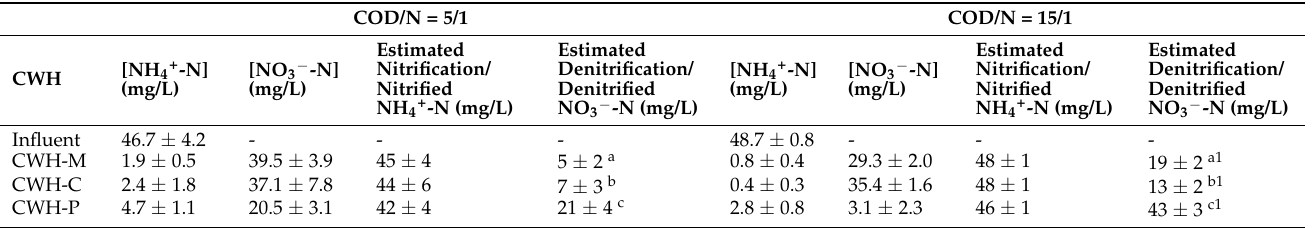
Table 2. Influent and effluent NH 4+ -N concentration, effluent NO 3 − -N concentration, estimated nitrification, and denitrification (mg/L) with standard error in CWH over the experimental period at both COD/N ratios. CWH-M, CWH-C, and CWH-P indicate mineral wool, cocopeat, and pumice without plants, respectively. The denoted values of (a and a1), (b and b1), (c and c1), (a and c), (b and c), and (a1, b1, and c1) are statistically significant according to t